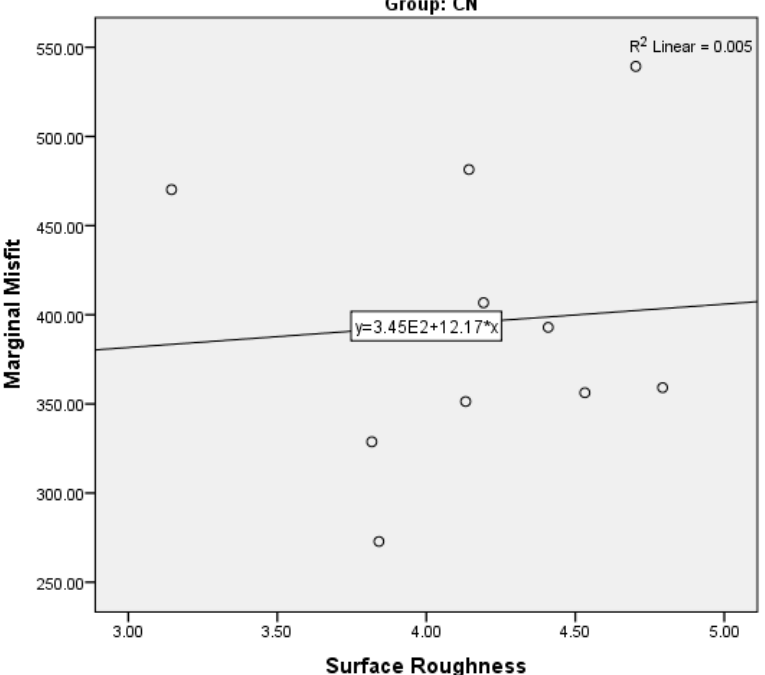
Figure 13. Scatter plot for the correlation between marginal misfit and surface roughness for the CN samples.